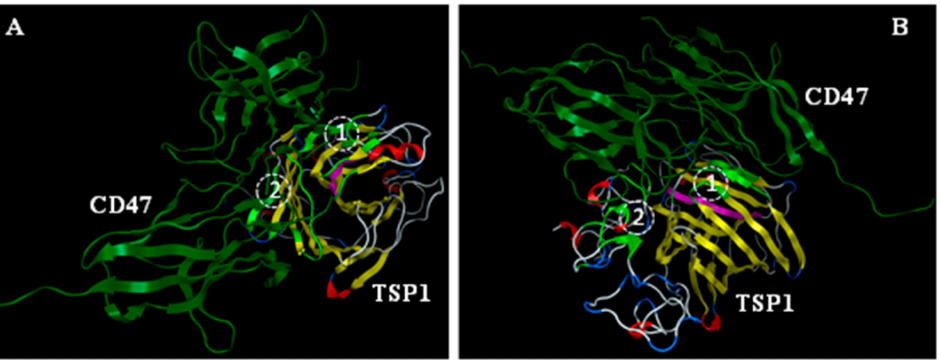
Figure 1. Molecular simulation of ligand, TSP1, interaction with the receptor (CD47) in a solvent-free environment. Slightly open conformation of the 4N1K hydrophobic cleft (RFYVVMWK peptide region, pink) on TSP1 C-terminal domain was modeled via Molecular Operating Environment (MOE) to participate in interaction with the N-terminus of the model of the soluble extracellular part of the CD47 receptor (shown in two mode views, ( A , B ), as identified experimentally, in addition to the two putative TSP1:CD47 interaction regions (1) and (2), respectively, as recognized earlier. Light green: residues of TSP1 involved in